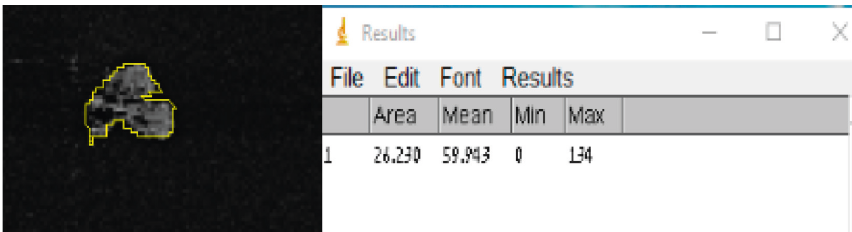
Figure 4: Example of the method used for the demarcation (left, yellow outline) and measurement of retinal NV using the OCTA scan and ImageJ (right). Table 3: Summary of retinal neovascularization size at baseline and at the 6-month follow-up. Case